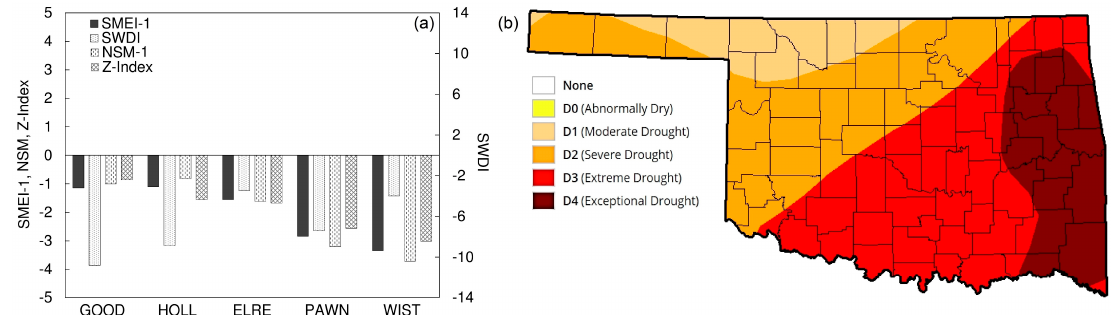
Figure 6. Magnitudes of selected drought indices for February 2006 at study sites ( a ) and the corresponding U.S. Drought Monitor (USDM) map ( b ).